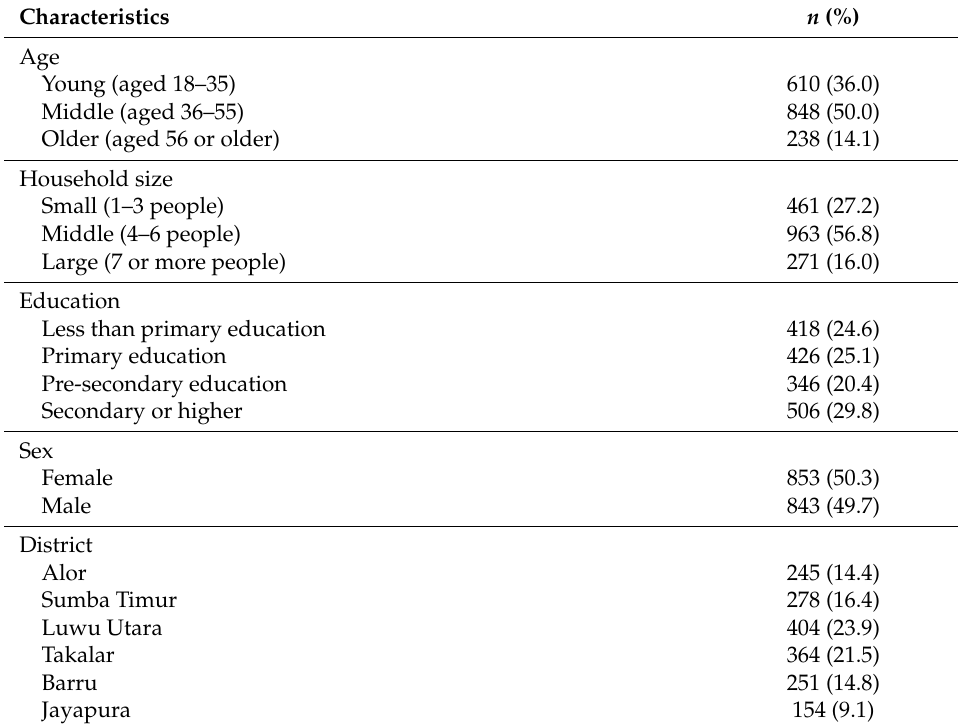
Table 1. Descriptive analysis of study variables, n =